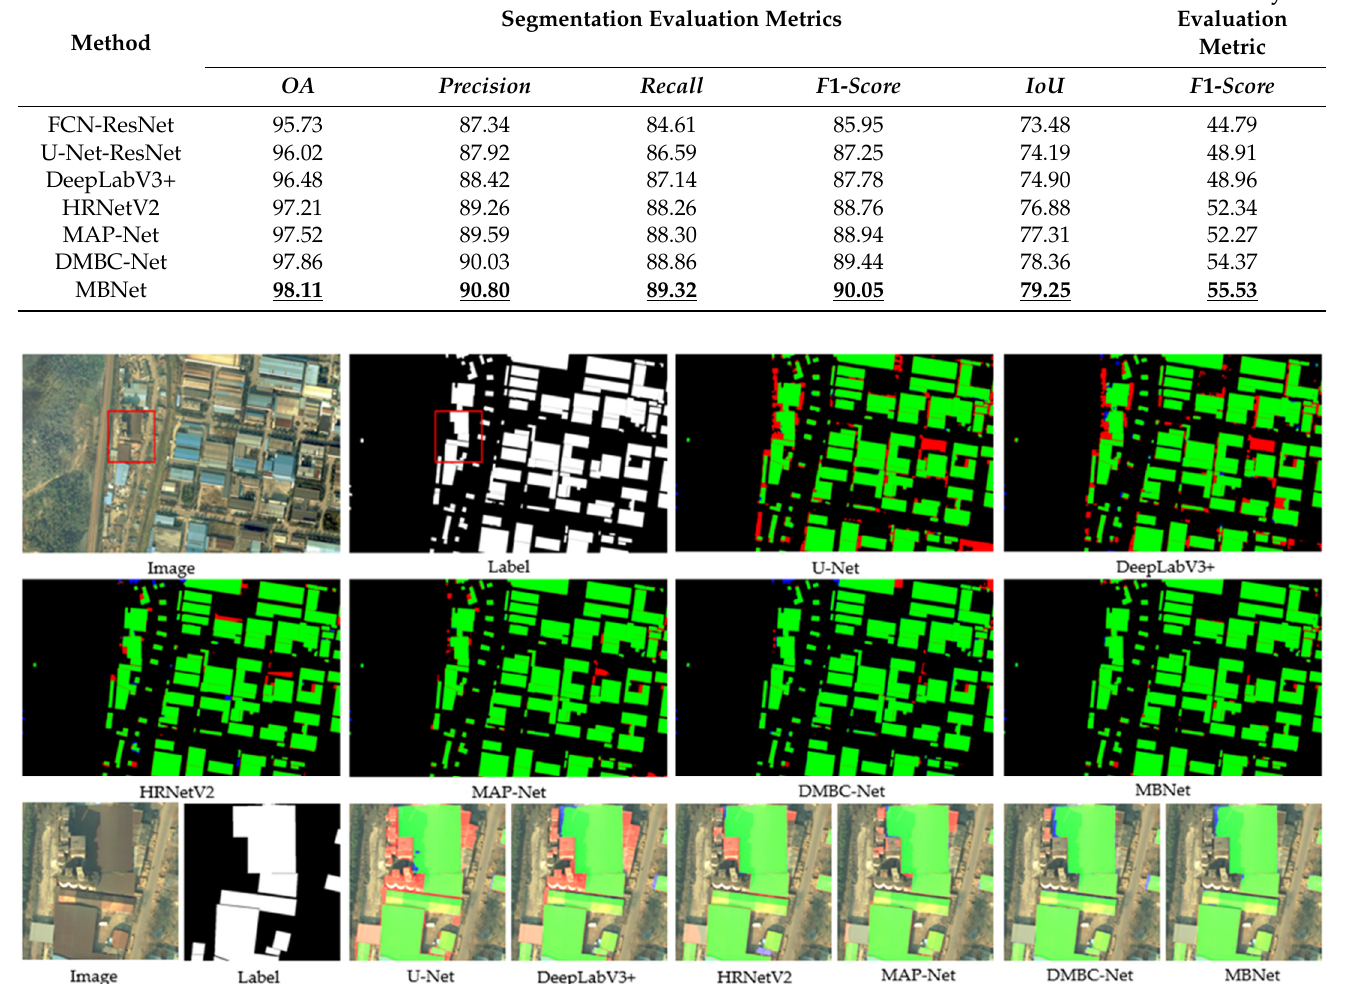
Table 4. Quantitative evaluation (%) of several SOTA algorithms on remote sensing images of suburban in the test set, where values in bold and underlined are the best.